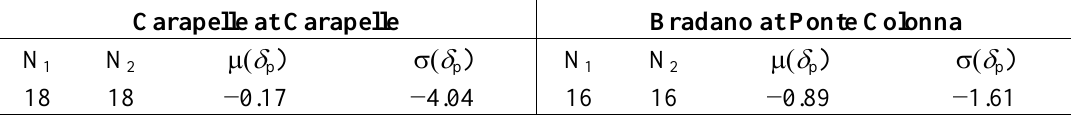
Table 4. Application of generalization criterion for model